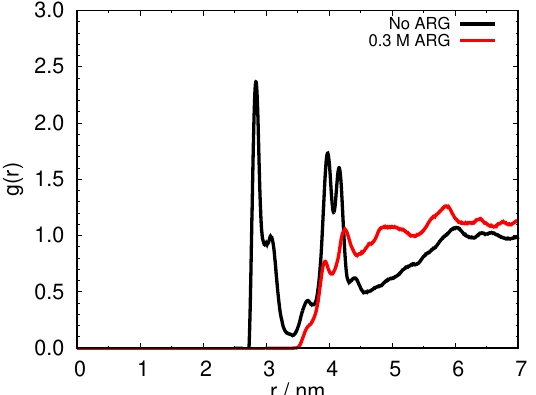
Figure 3. Protein–protein COM pair distribution function for 93 mg mL − 1 aqueous HEWL solution at 267 K with (red) and without (black) added